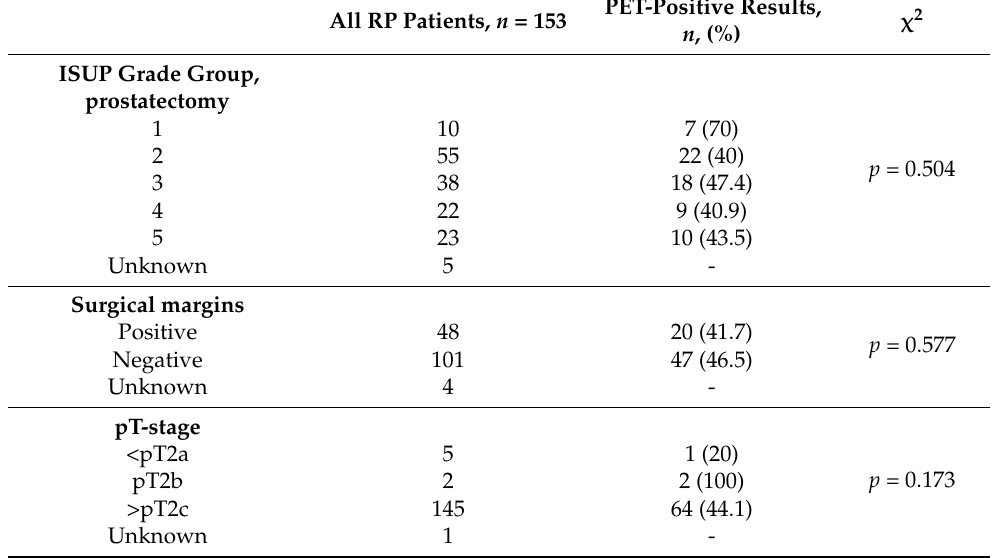
Table 3. Patients initially treated with